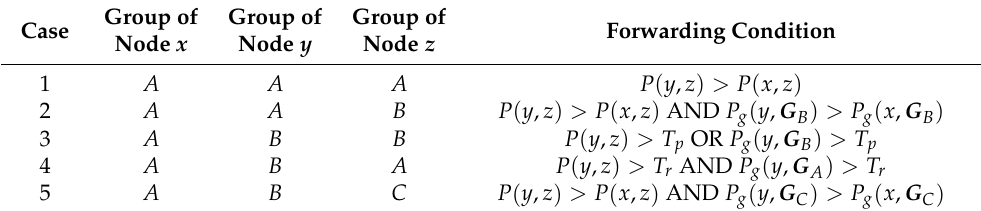
Table 1. Forwarding conditions of the proposed